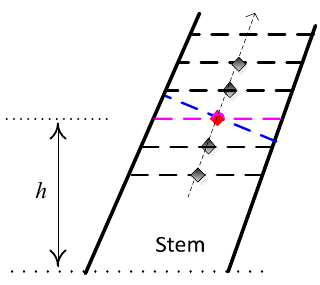
Figure 3. Diagram representing the method for the determination of a stem cross-sectional plane at a given height. The red point represents the anchor point. The pink dashed line represents the initial plane. The blue dashed line represents the stem cross-section corresponding to the anchor point. The direction of the arrow represents the growth direction of the stem at height h . Two adjacent stem cross-sections form a stem slice.